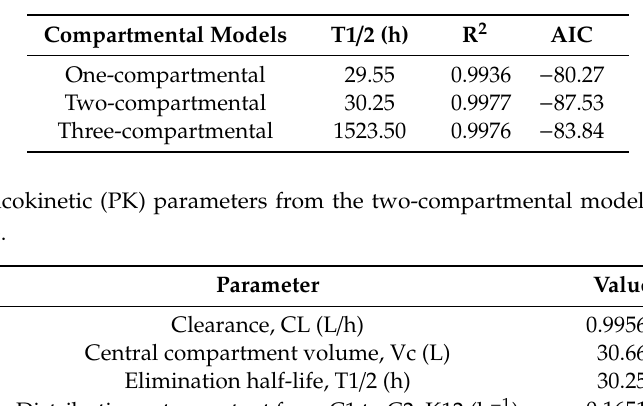
Table 2. Elimination half-life (T1 / 2), coe ffi cient of determination (R 2 ), and Akaike Information Criterion (AIC) for compartmental models calculated by PKPlus ™ module.